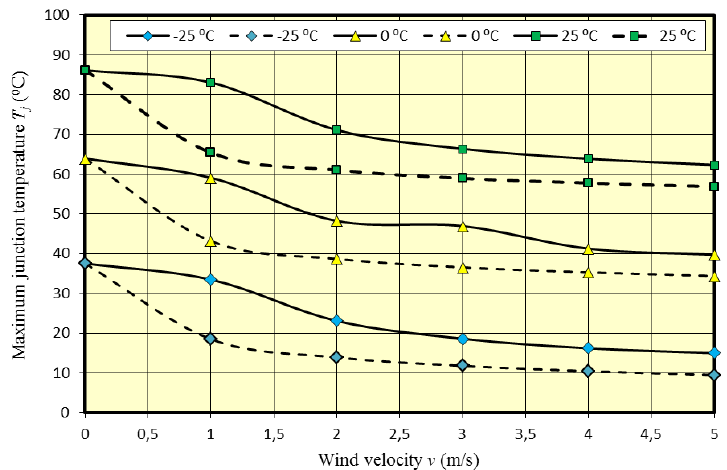
Figure 20. Maximum junction temperature T j of the installed LED panel sources in the function of wind speed v.